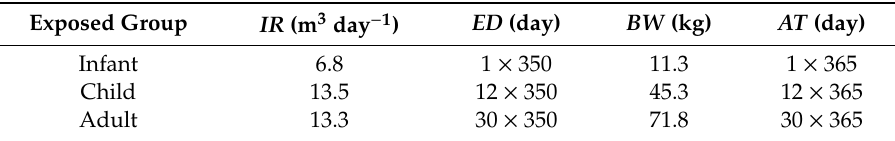
Table 4. Parameters for health risk assessment of main air pollutants through the inhalation pathway. IR is the average values of inhalation rate, ED is the exposure duration, BW is the average weight, and AT is the averaging